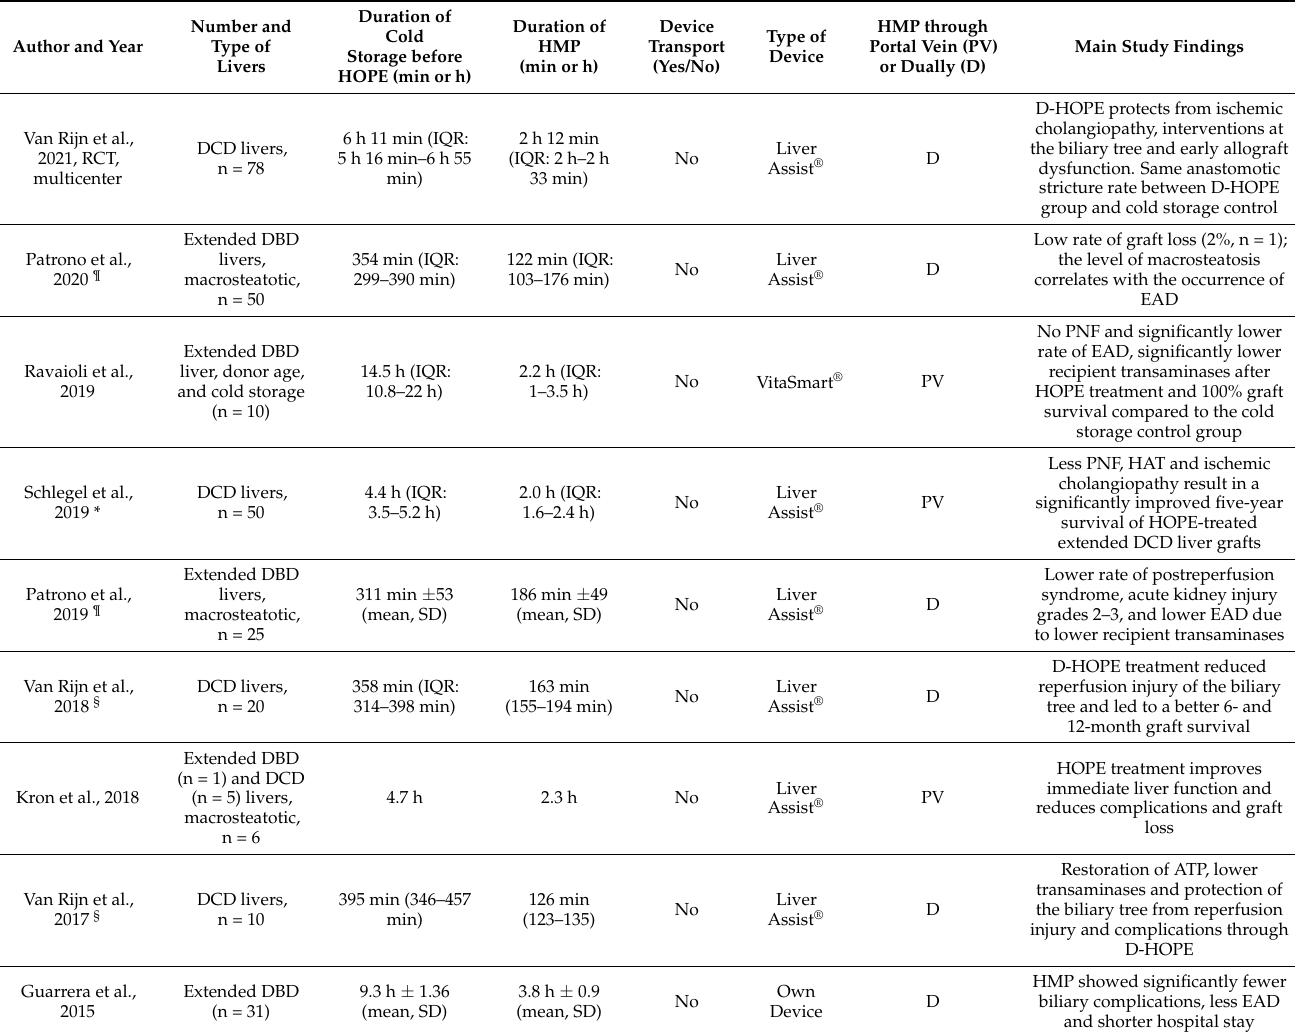
Table 1. Overview on clinical studies with hypothermic liver perfusion before liver transplantation. This table summarizes clinical studies with hypothermic liver perfusion (HOPE, D-HOPE, HMP, HMP-O 2 ) within the last 10